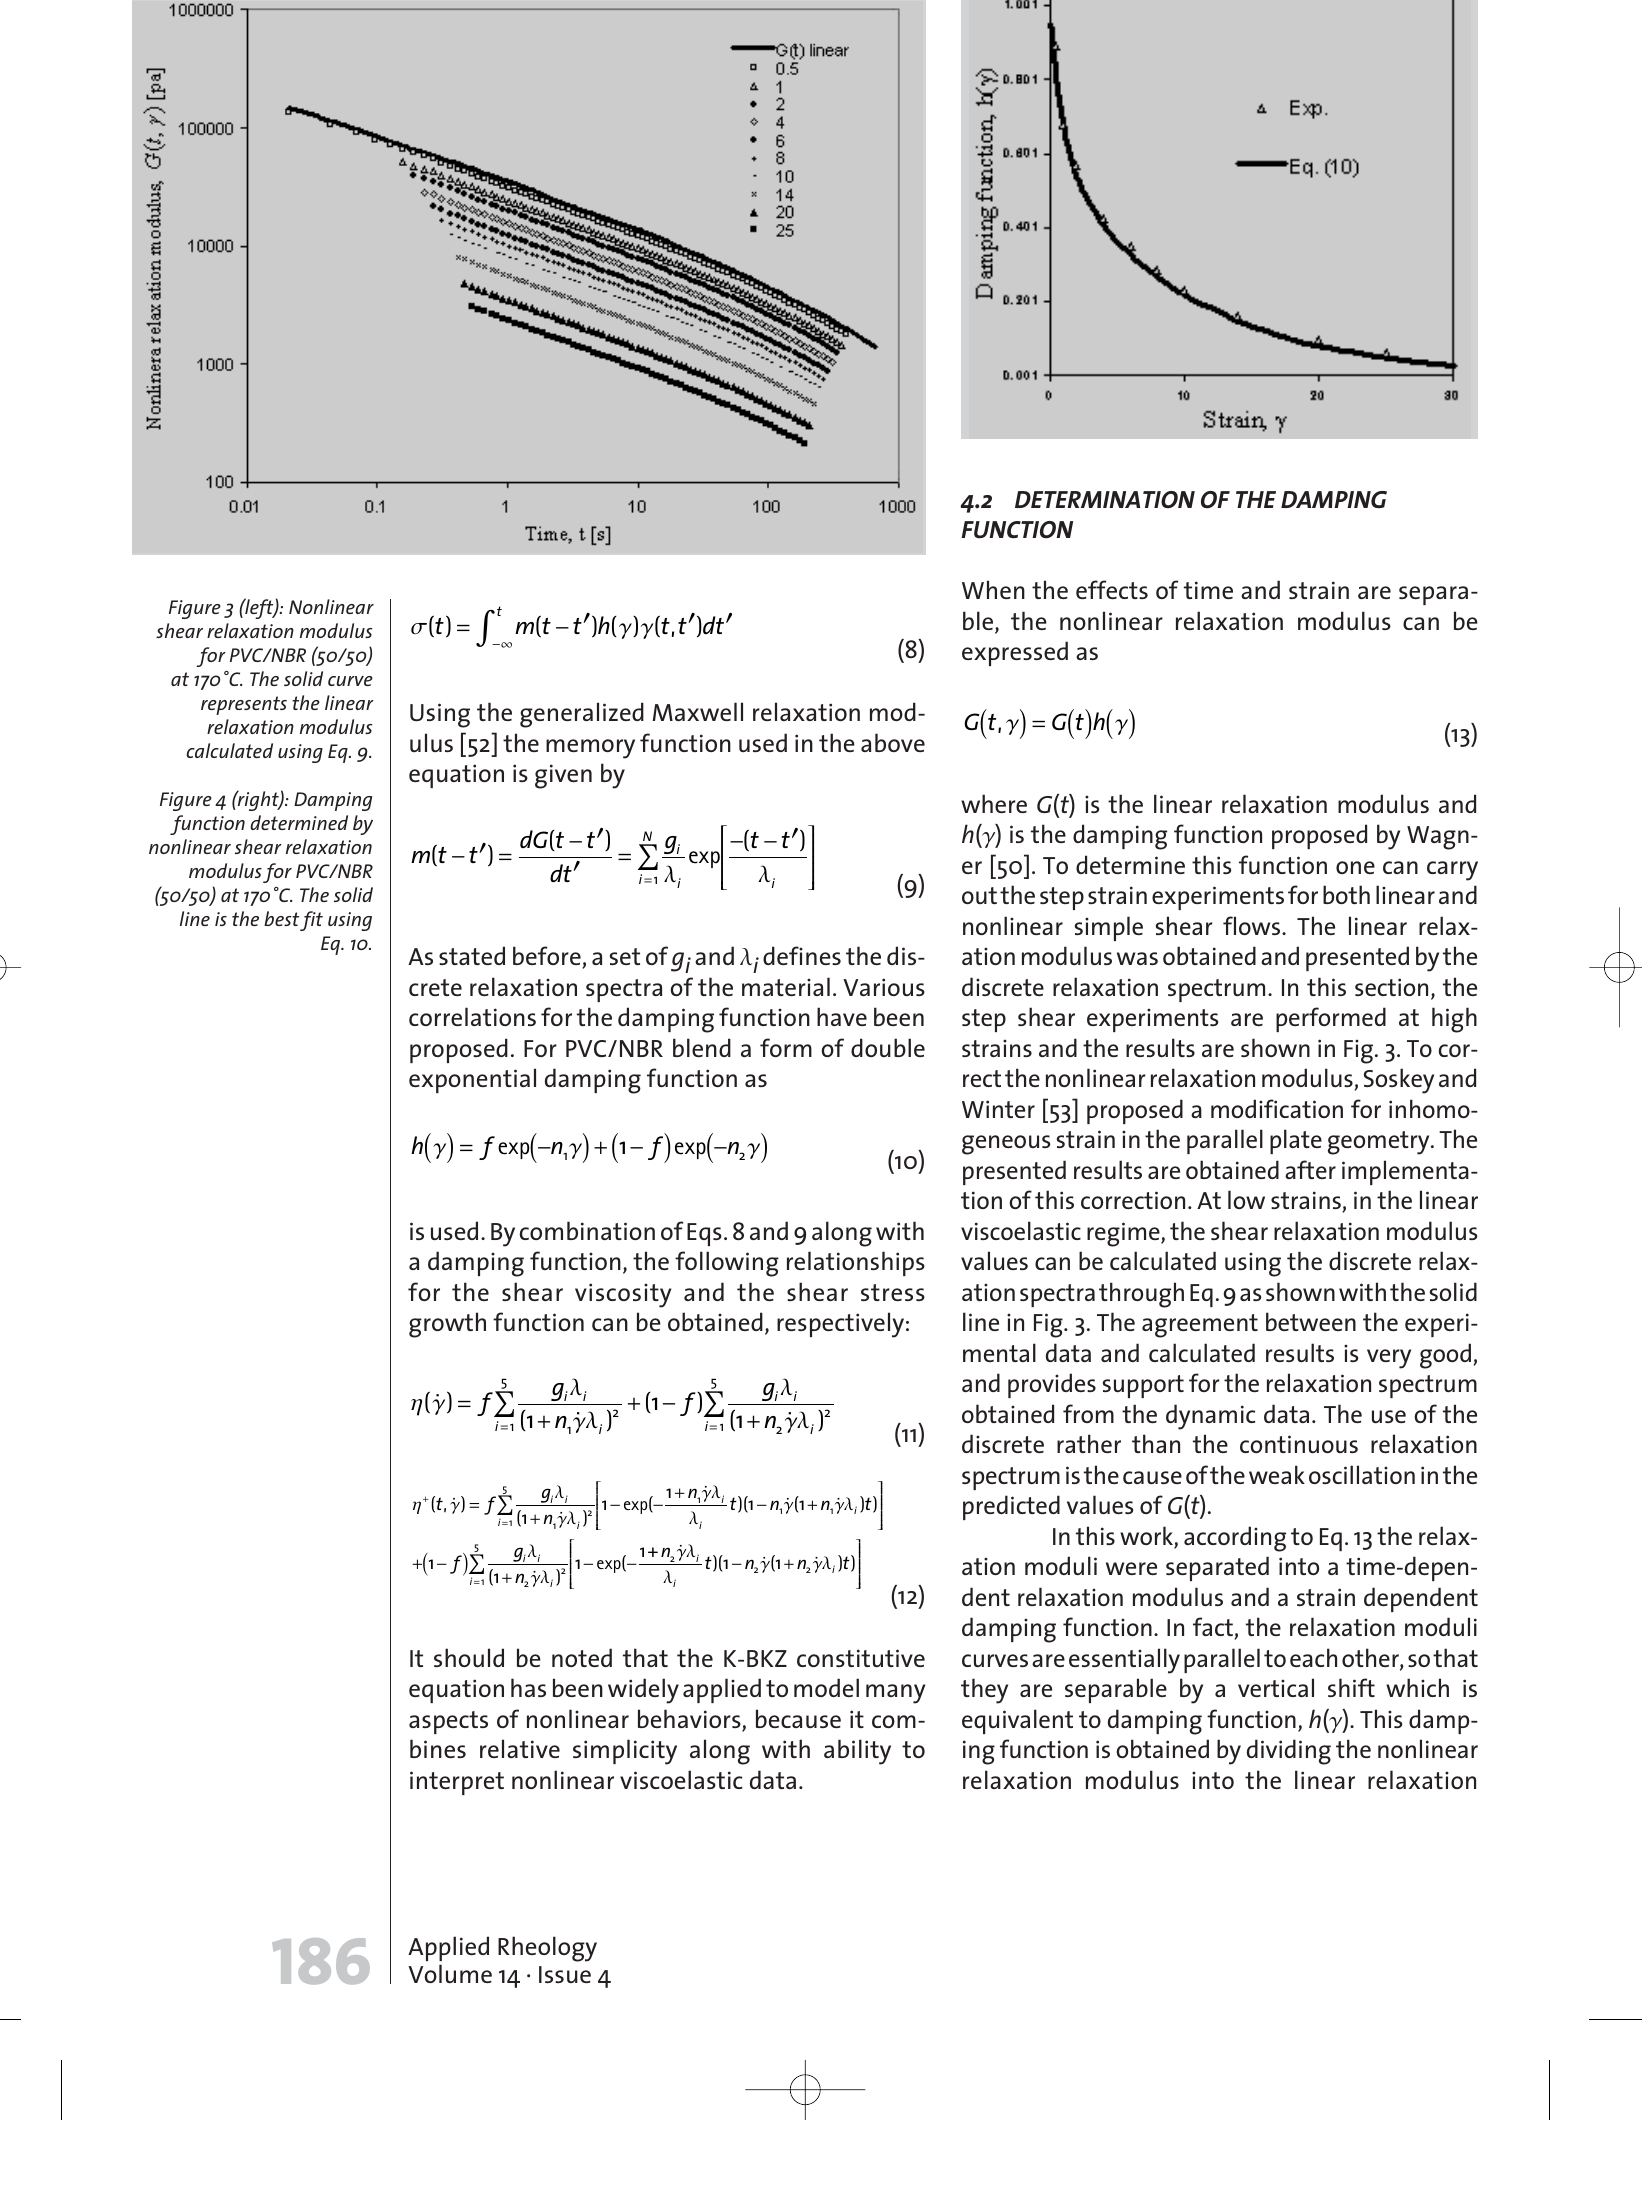
Figure 3 (left): Nonlinear shear relaxation modulus for PVC/NBR (50/50) at 170˚C. The solid curve represents the linear relaxation modulus calculated using Eq. 9. Figure 4 (right): Damping function determined by nonlinear shear relaxation modulus for PVC/NBR (50/50) at 170˚C. The solid line is the best fit using Eq.